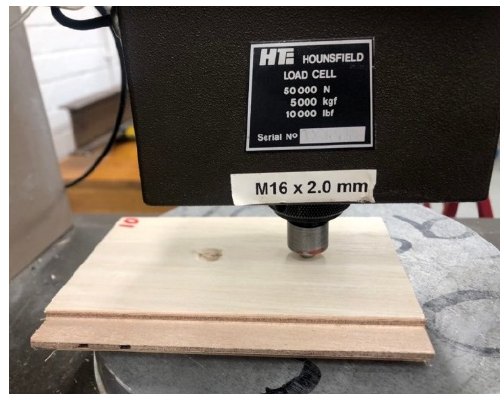
Figure 3. Adapted Janka test on E. nitens engineered flooring surface .